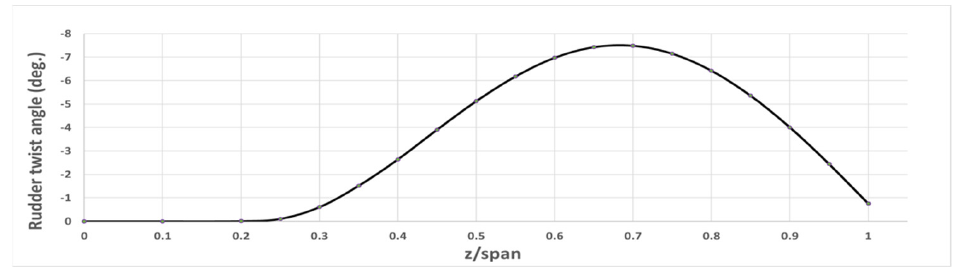
Figure 20. Twist angle distribution designed by the information on the flat-type rudder inflow.